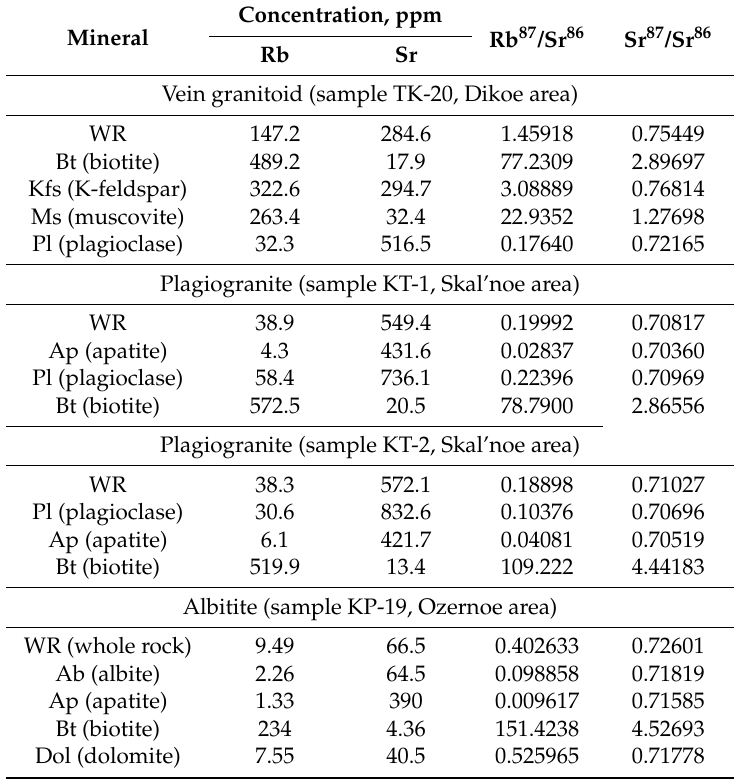
Table 2. Rb-Sr data for rocks and minerals of uranium occurrences in the Litsa area and the Salla-Kuolajarvi belt.